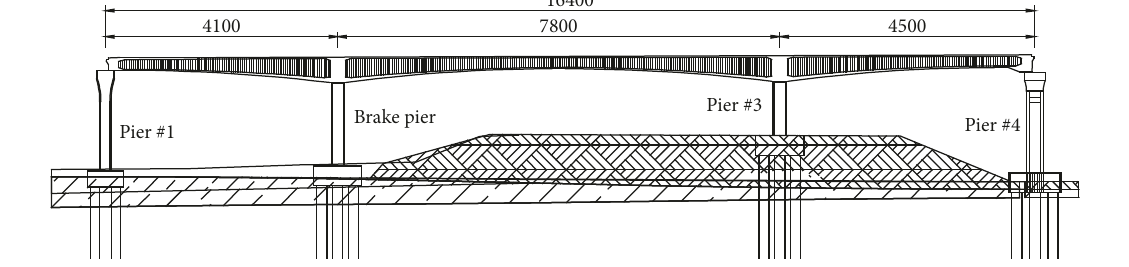
Figure 19: General layout of the bridge. Table 4: Cases for calculation.